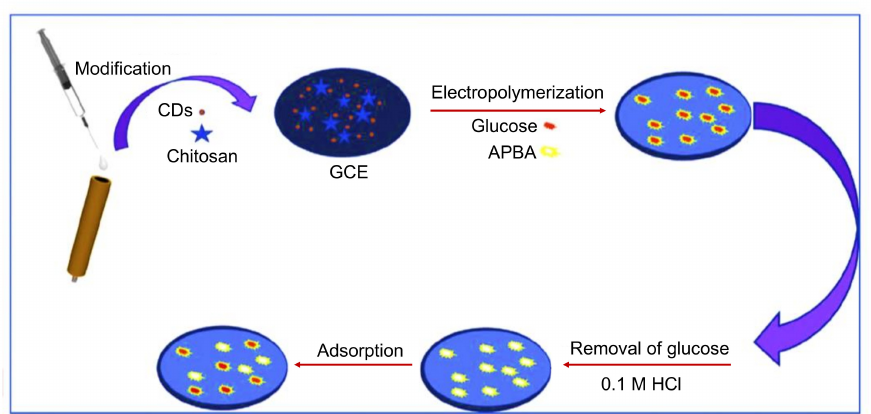
Figure 16. Fabrication steps of an MIP/chitosan-CDs@GCE surface. Reproduced from [232], with permission from Elsevier,